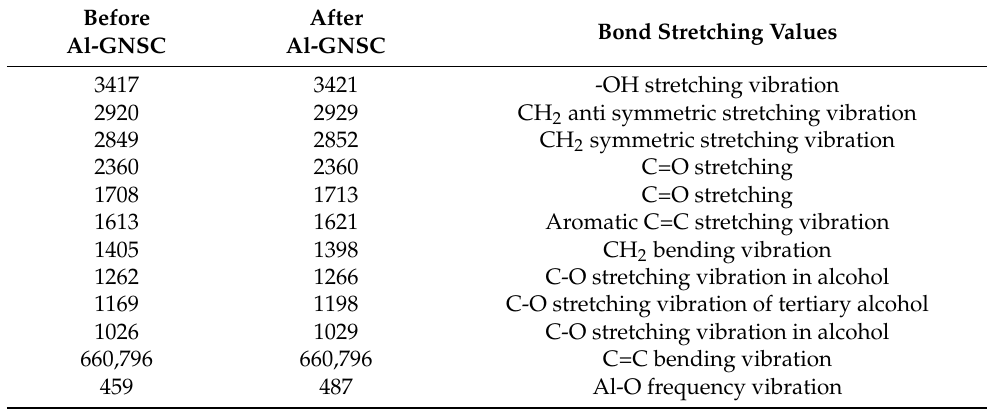
Table 1. FT-IR data of Al-GNSC before and after Cr(VI) adsorption.